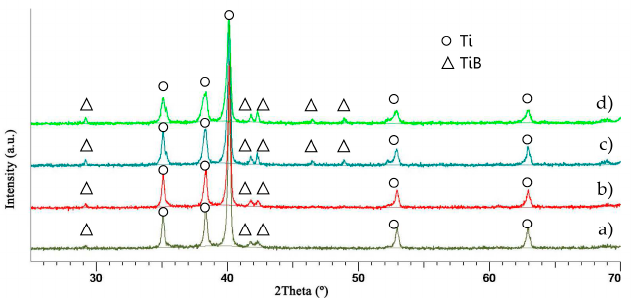
Figure 7. XRD patterns of composites manufacture with 5 vol % of B for 15 min via iHP at different temperatures: ( a ) 1000 °C; ( b ) 1100 °C; ( c ) 1200 °C; and ( d ) 1300 °C.